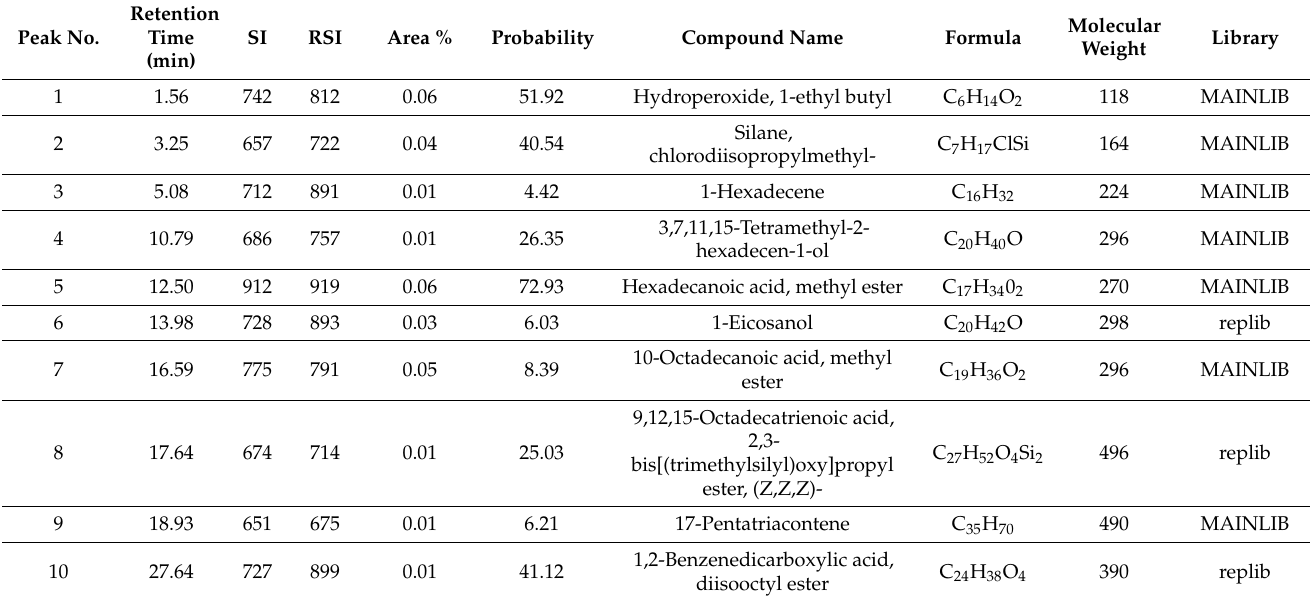
Figure 2. GC-MS chromatogram of the dichloromethane fraction (DCMC) of Chrozophora tinctoria. The numbers inside the chromatogram are the retention times of the compounds. Table 2. Bioactive compounds identified in DCMC through